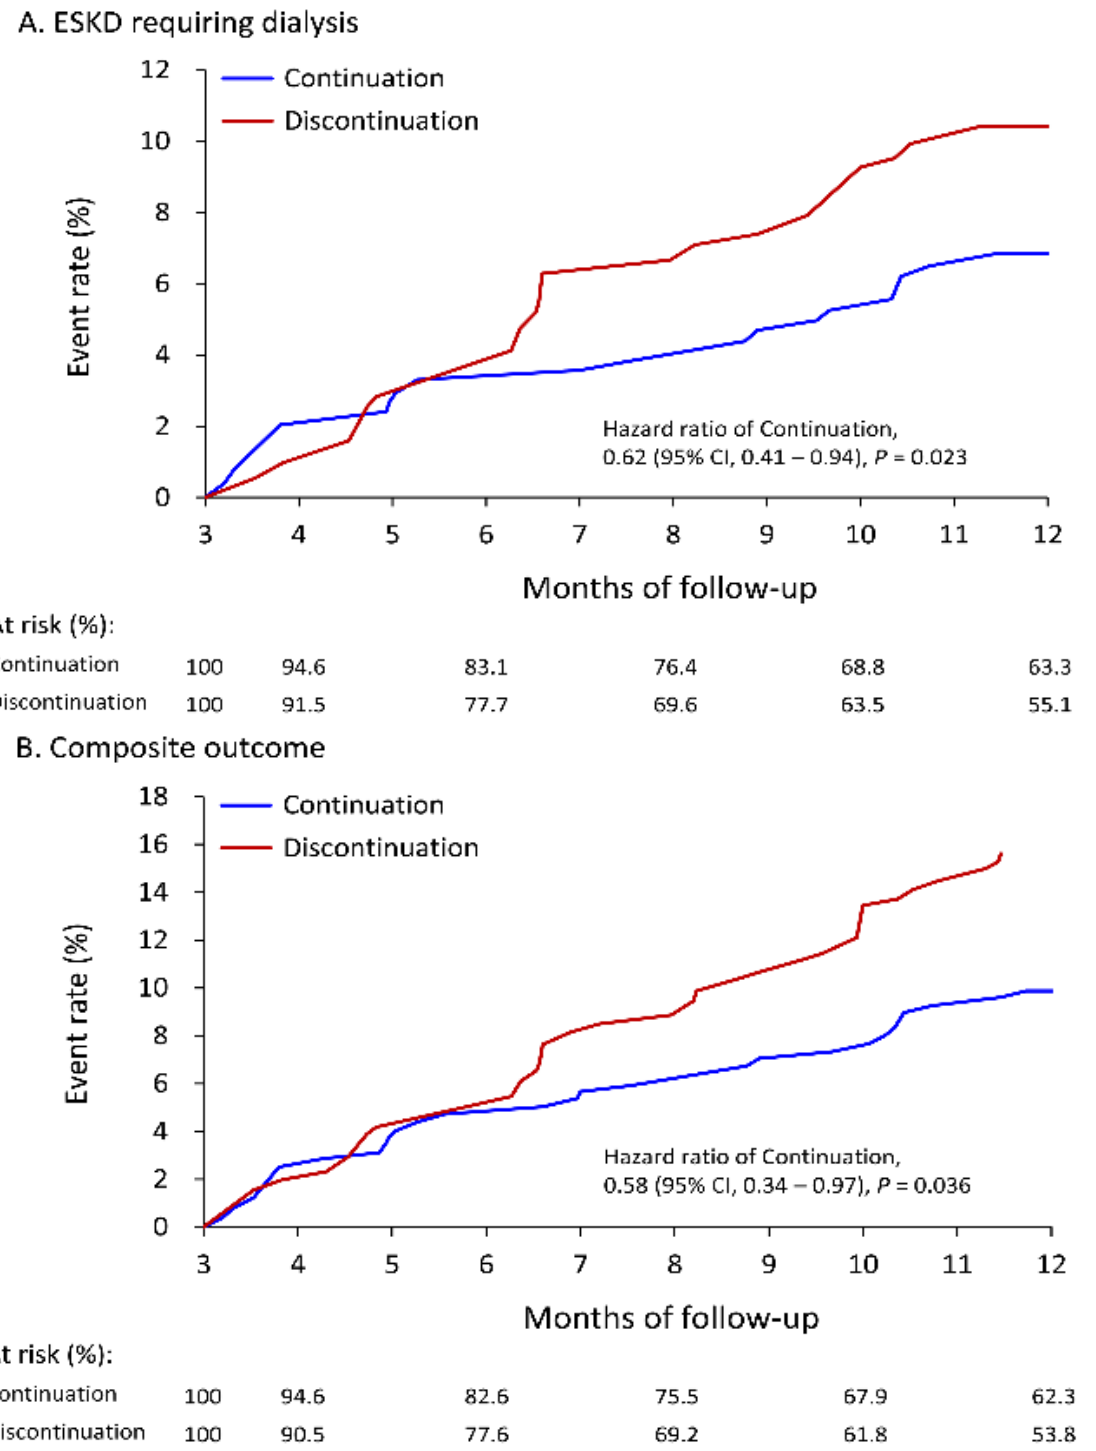
Figure 2. Cumulative event rate of ESKD requiring dialysis ( A ) and composite outcome ( B ) during 1-year follow up of patients receiving ketoanalogues supplemental low protein diet in the IPTW adjusted cohort. The composite outcome included anyone of ESKD requiring dialysis, cardiovascu- lar death, acute myocardial infarction, ischemic stroke and all-cause death. ESKD, end stage kidney disease; IPTW, inverse probability of treatment weighting.